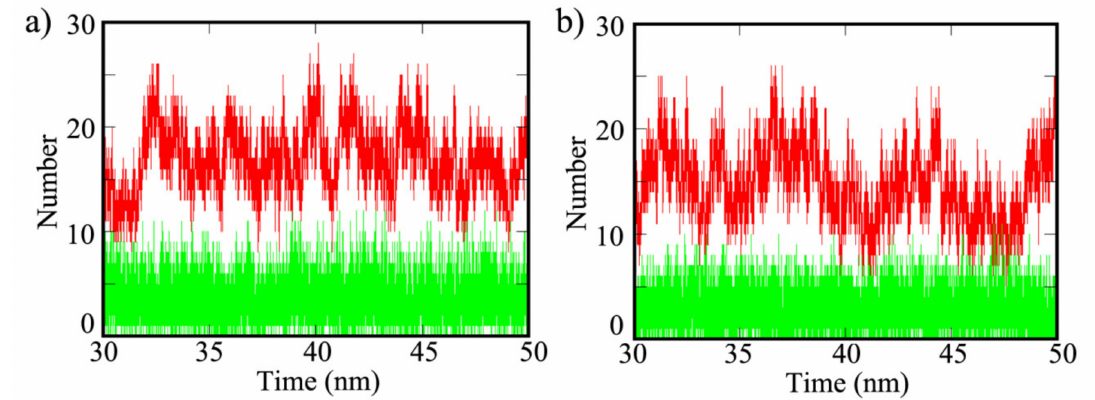
Figure 9. Hydrogen bond (HB) interactions of water (red) and ethanol (green) molecules on ( a ) COF-1 and ( b ) CTF-1.